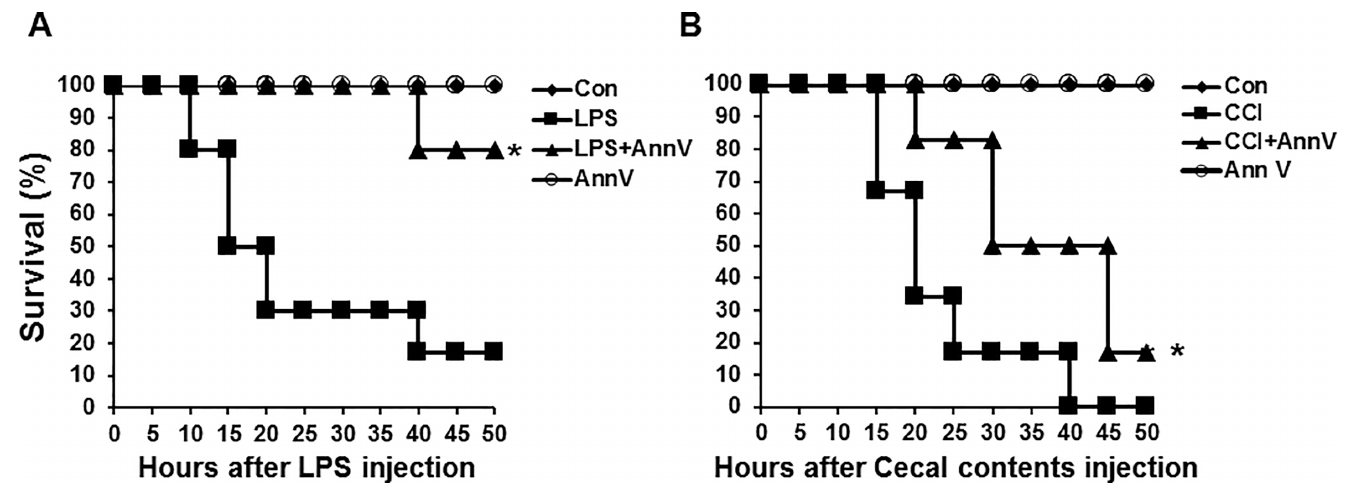
Figure 1. Annexin A5 treatment enhances survival in LPS-induced and cecal content injection-induced sepsis model. (A) endotoxemia model: C57BL/6 mice were intraperitoneally injected with lethal doses of LPS, 50 mg/kg. Concurrently, each mouse was injected intrave- nously with 500 μ g annexin A5 (in 100 μ L PBS) and monitored for 50 h. * - indicates significant differences ( P < 0.05) from data obtained during the LPS-only challenge. (B) cecal content injection model: C57BL/6 mice were intraperitoneally injected with 20 mg of cecal con- tents. Each mouse was intravenously injected with 500 μ g (in 100 μ L PBS) annexin A5 protein concurrently with CCI challenge and